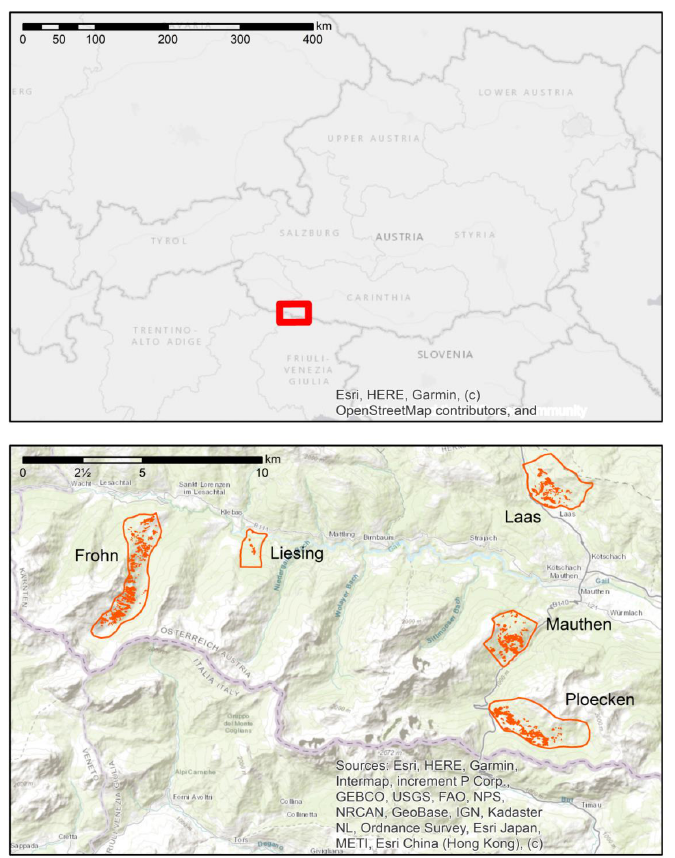
Figure 1. Location of the area under investigation in Austria, and locations of the blowdown areas in the five forest districts (Frohn, Liesing, Laas, Mauthen and Ploecken). Forest district borders are represented by the orange polygon lines, windthrow areas within the forest subdistricts are represented by orange-filled polygons.